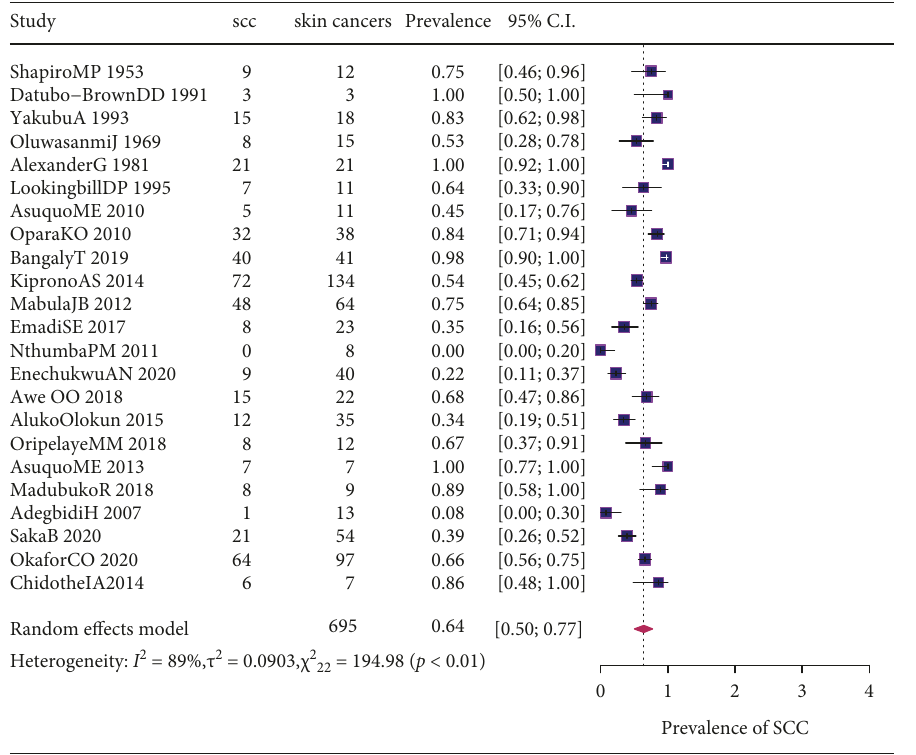
Figure 2: Forest plot showing the pooled prevalence of squamous cell carcinoma in 23 included